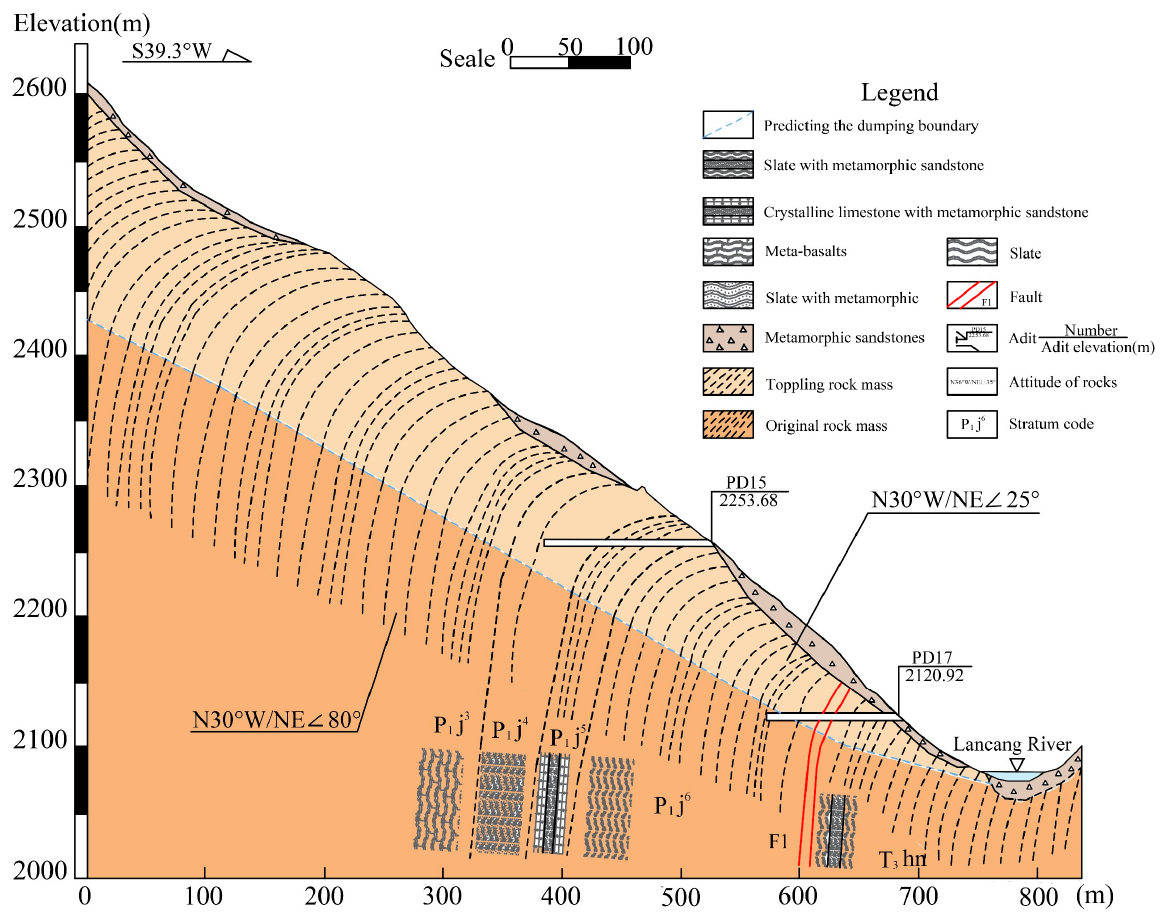
Figure 3. Engineering geological profiles of the slope.